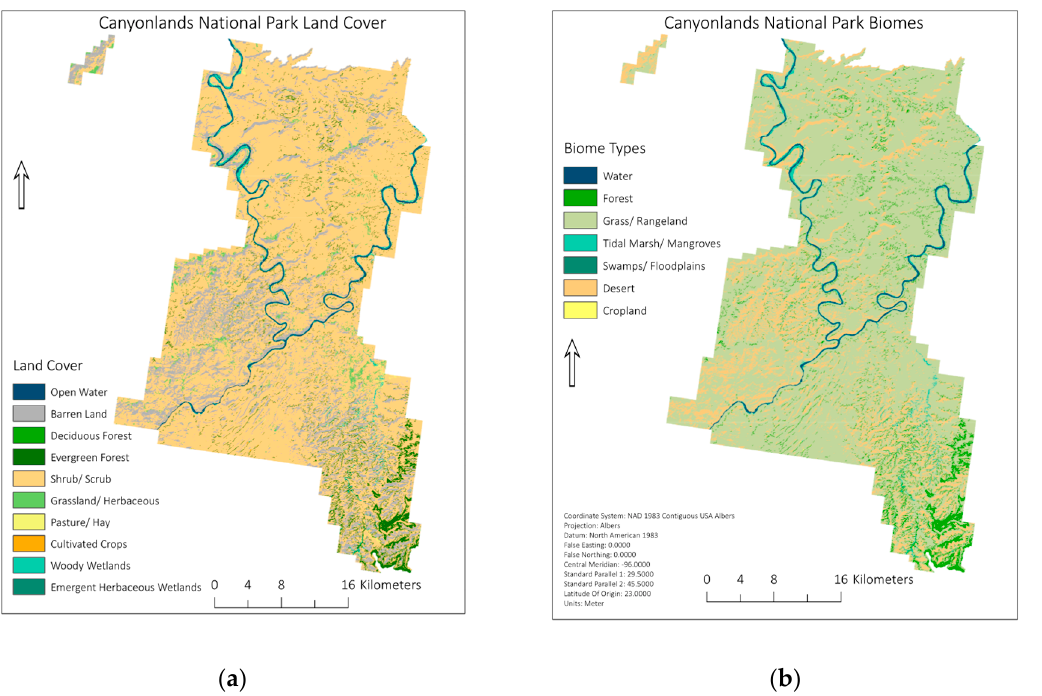
Figure 2. Land cover (NLCD) and Biomes (ESV) for Canyonlands National Park